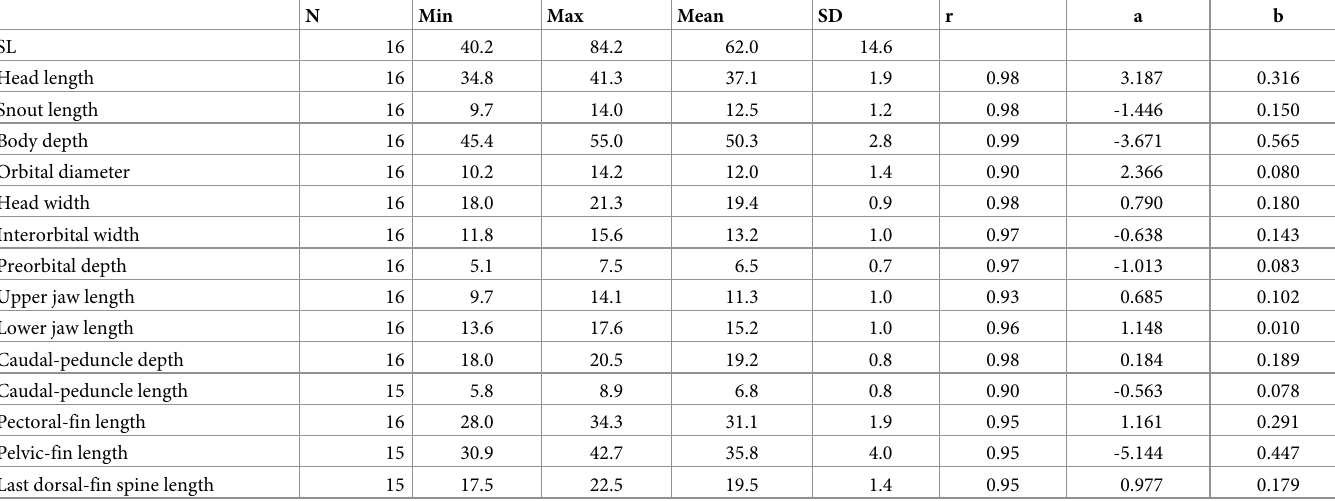
Table 16. Australoheros sanguineus . Size (SL), proportional measurements (per cent of SL), and linear regression parameters.